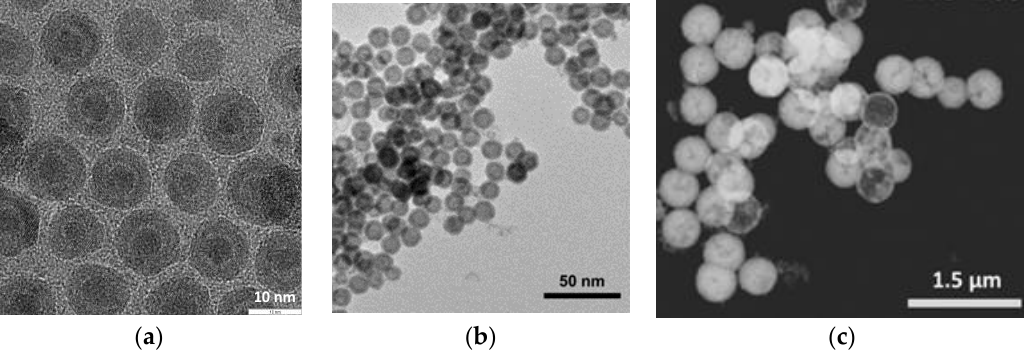
Figure 7. TEM image of ( a ) Fe@Fe 3 O 4 @OA NPs 13 nm, ( b ) small hollow Fe 3 O 4 @OA NPs and ( c ) STEM of large hollow Fe 3 O 4 @OA NPs.